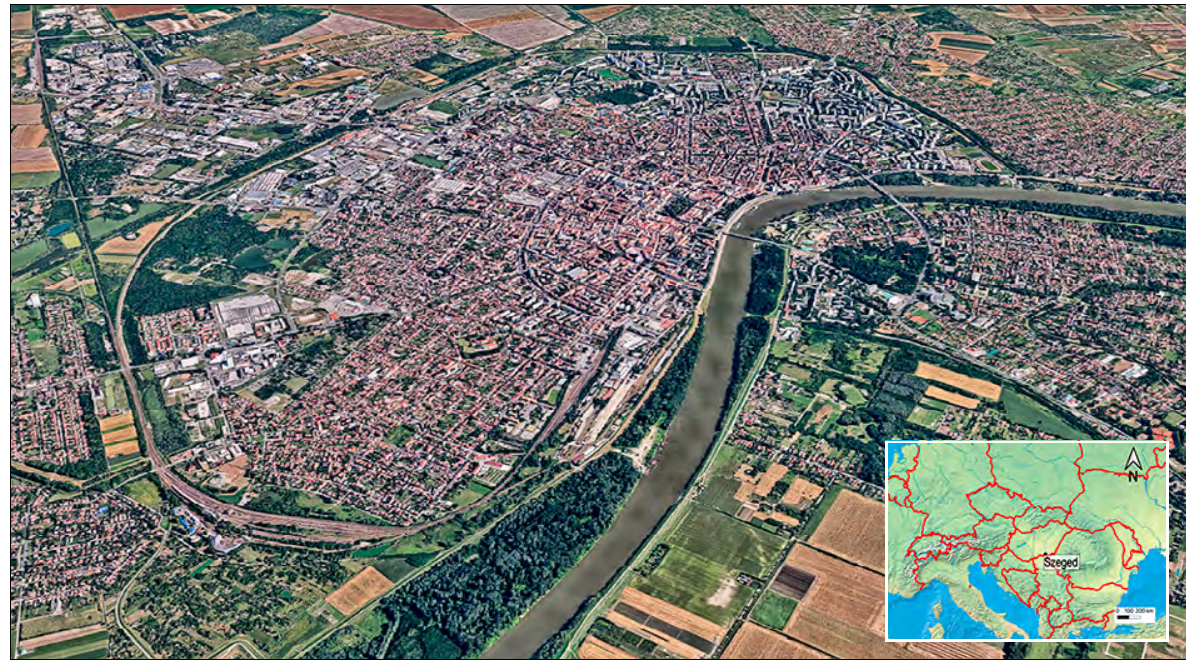
Figure 1. The geographical location of Szeged in Hungary and Europe, and its aerial